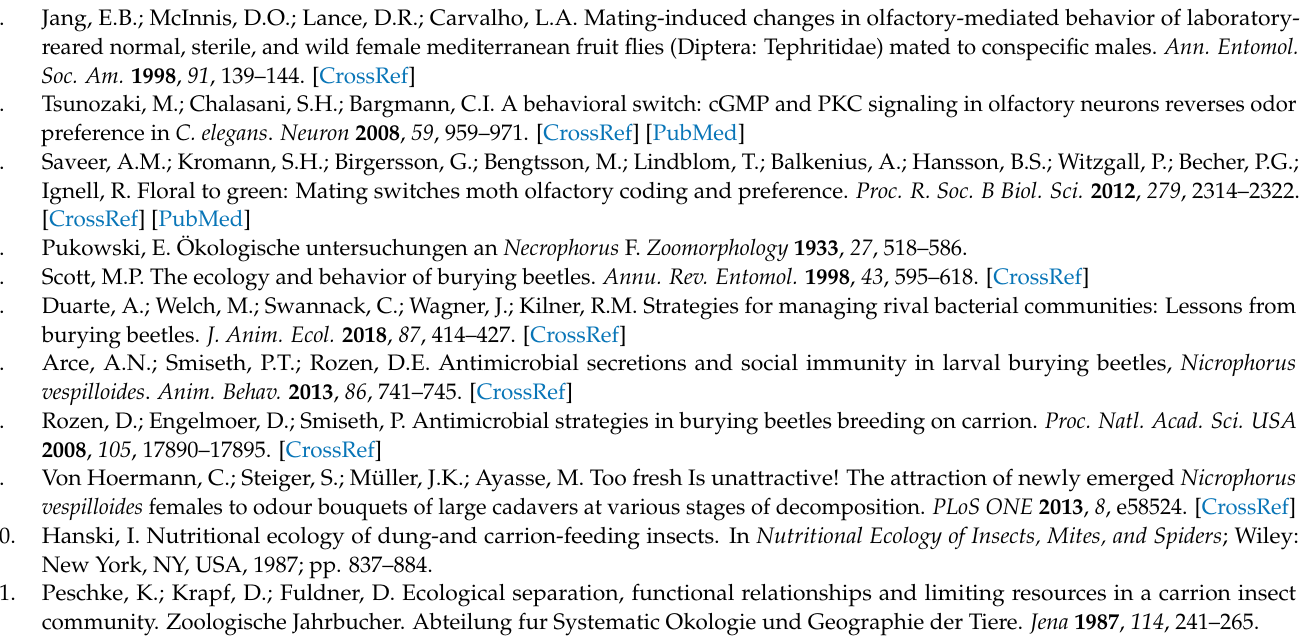
olfactory preference, Figure S3: Preference estimated as the percentage of females that visit a given cue chamber first. Table S1: Volatile organic compound abundances (relative to internal standard) in individual mouse